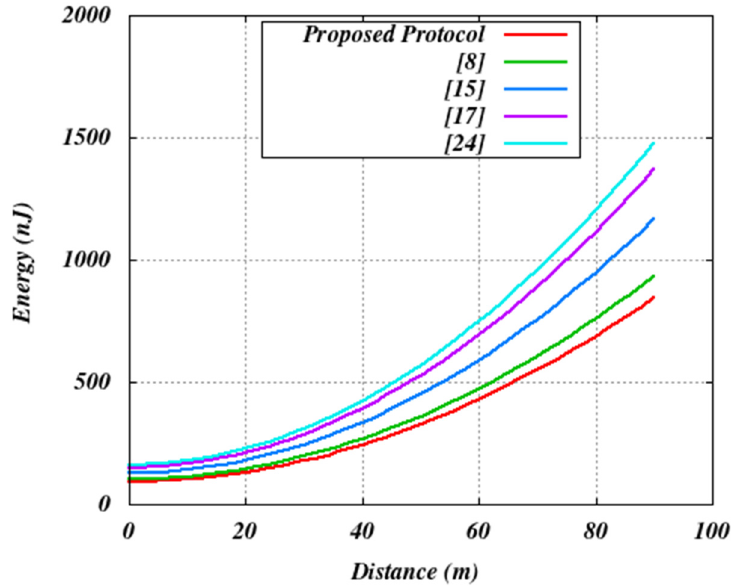
Figure 13. Energy overhead consumption.